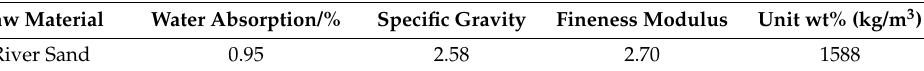
Table 2. Physical properties of river sand.